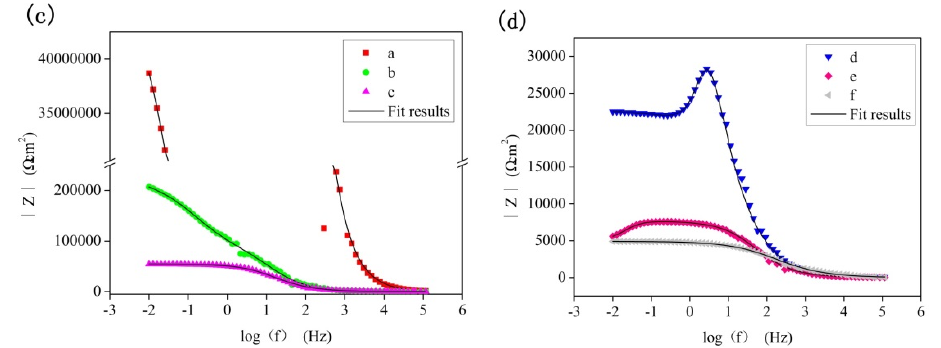
Figure 10. Electrochemical impedance spectroscopy (EIS) plots and fitting results of the MAO immersion coatings carried out in 3.5 wt % NaCl solution: ( a , b ) Nyquist plot, ( c , d ) Bode plot of Z vs. frequency. ( a ) 24 h, ( b ) 48 h, ( c ) 96 h, ( d ) 192 h, ( e ) 384 h, and (f) 768 h.